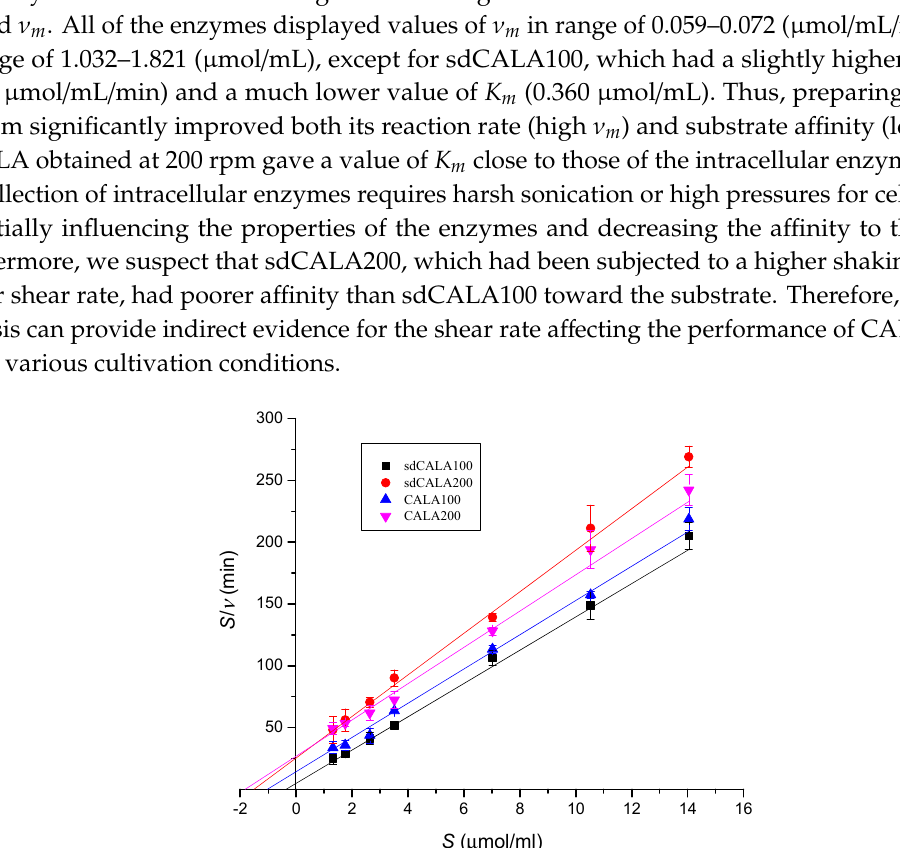
Figure 5. Effect of pH on the relative activities of CALA and sdCALA samples prepared at different shaking rates.